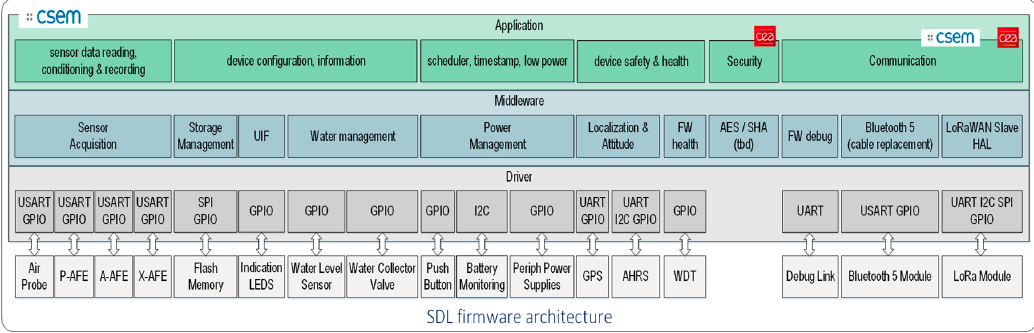
Figure 12. Smart Data Logger firmware architecture .